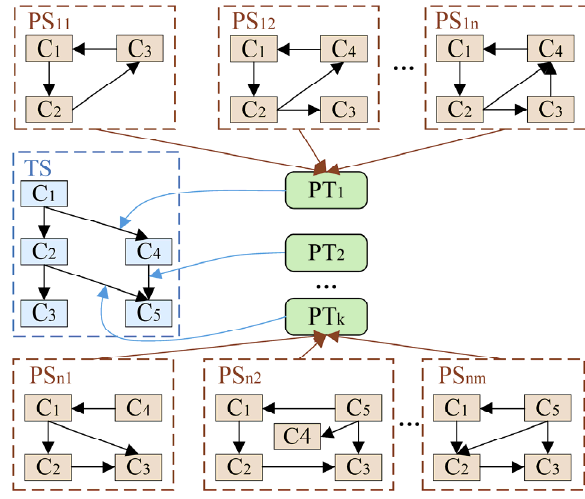
Figure 7. Technological solution mapping.